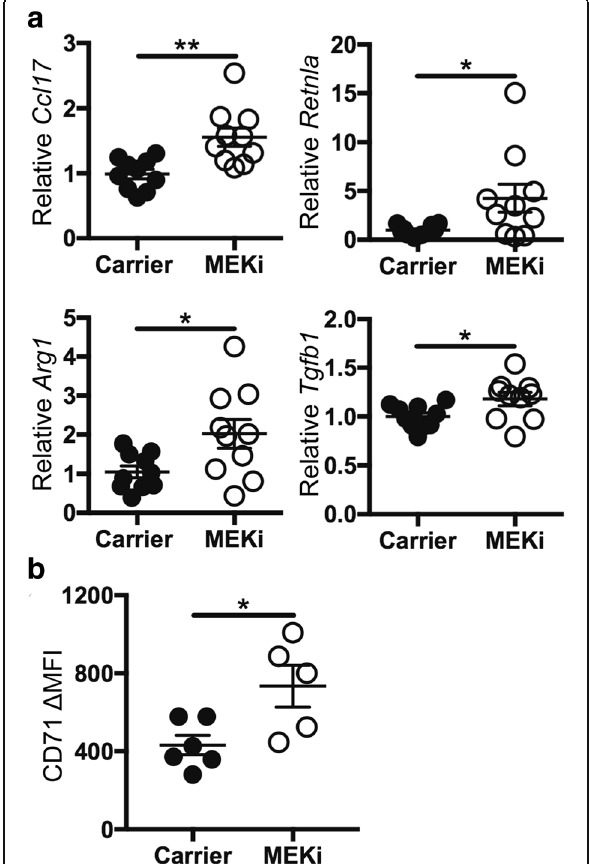
Fig. 2 MEKi modulates in vivo macrophage polarization. Alveolar macrophages were obtained from BAL a and lungs b from C57BL/6J mice 4 days after infection with 5 × 10 6 CFU P. aeruginosa that received carrier or MEKi treatments delivered by i.p. injection on days 2 and 3 after infection. a Alveolar macrophages from BAL were isolated and used for measurement of M2 gene expression. The levels of Ccl17 , Retnla , Arg1 , and Tgfb1 were measured relative to Hprt control and data were normalized to carrier-treated animals; n = 10/group. Error bars show the mean ± SEM, analyses used parametric unpaired t -test. b Single cell suspensions of cells obtained after lung digestion were used for staining and flow cytometry analyses. Alveolar macrophages were identified as CD45 + /Ly6G − /CD11c + /SigF + cells and the Δ MFI of carrier ( n = 6) and MEKi ( n = 5) treated mice from one representative experiment of two are shown. Error bars show the mean ± SEM, analyses used parametric unpaired t -test. * p < 0.05, ** p <